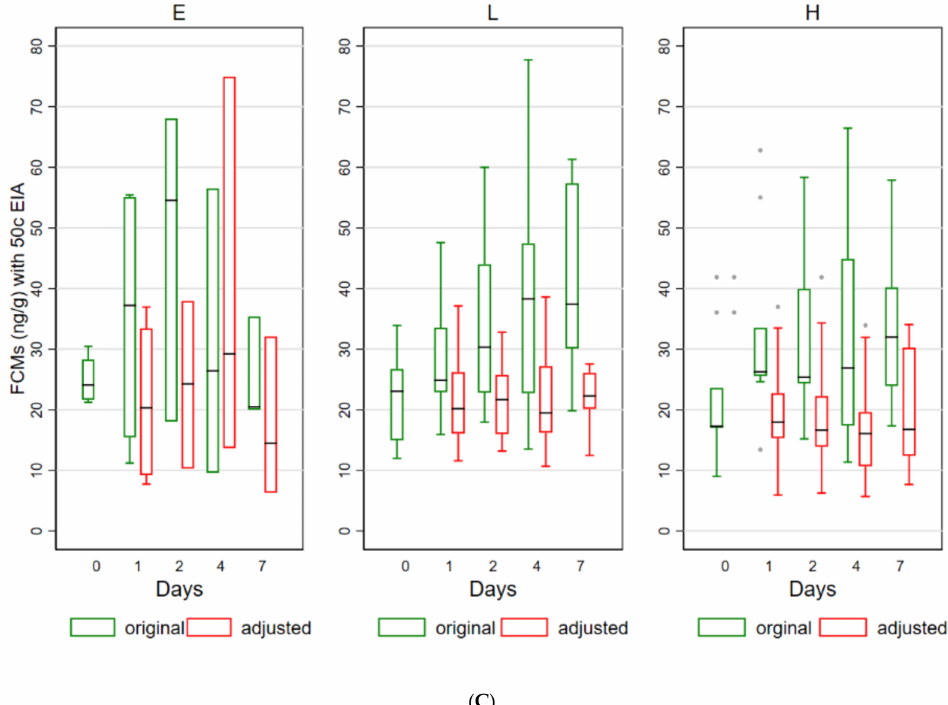
Figure 3. Box and whisker plots for original and adjusted FCM (faecal cortisol metabolite) values measured by the cortisol ( A ), the 37e ( B ), and the 50c ( C ) EIAs (enzyme immunoassays) over time in the three treatments E (environment), L (standard ambient T, 25 ◦ C), and H (high temperature, T and high relative humidity,